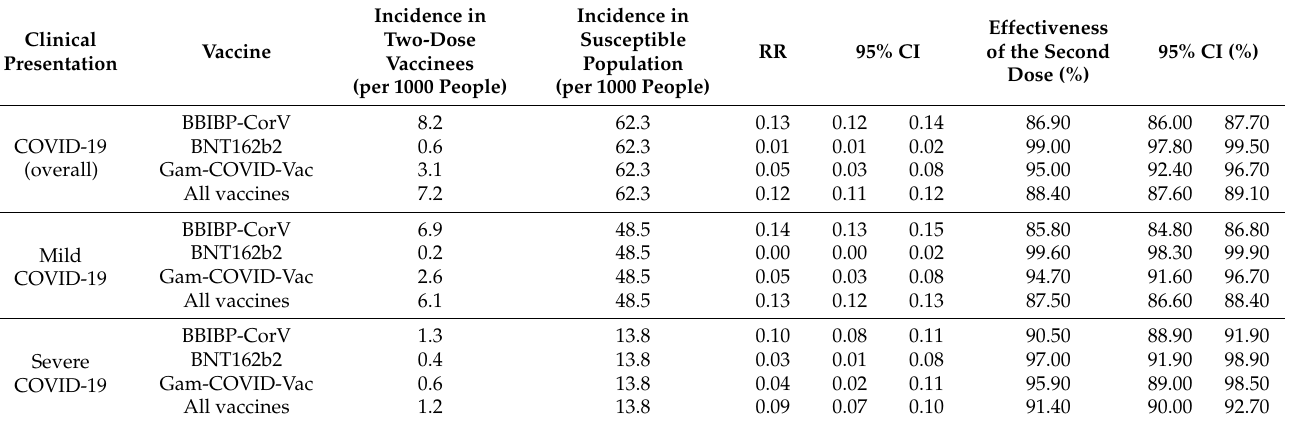
Table 2. Estimated effectiveness of the second dose of SARS-CoV-2 vaccines against COVID-19 outcomes, by clinical presentation and type of